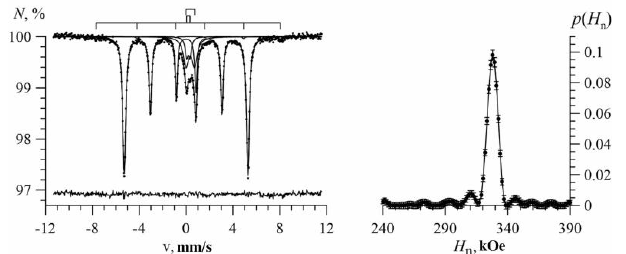
Figure 3. Mössbauer spectrum (left) and the result of reconstructing the distribution of the hyperfine magnetic field (right) of Fe nanotubes.